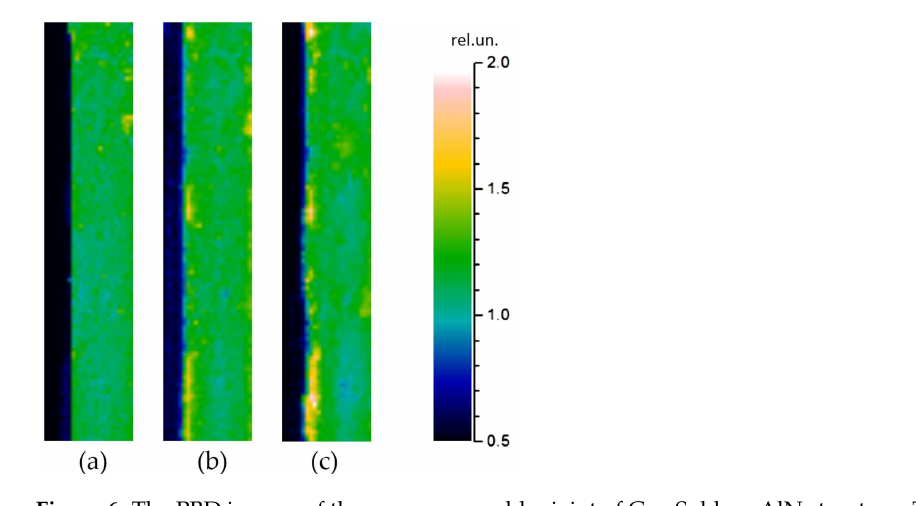
is 200 × 920 µm: ( a ) the sample in the initial state; ( b ) the sample after one cycle of cooling in liquid nitrogen; ( c ) the sample after 10 cycles. Adapted with permission from [68]. Copyright (2011), Pleiades Publishing, Inc.